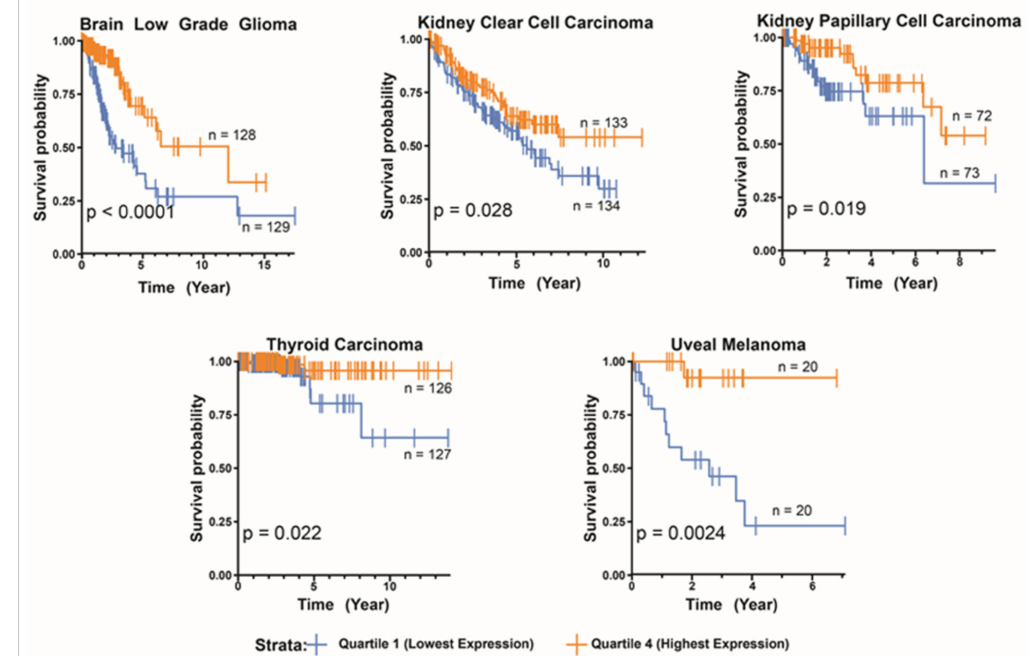
Figure 3. PC transcript levels in select tumor types correlate directly with survival. Normalized PC mRNA expression levels and Kaplan–Meier survival statistics were obtained from the TCGA PANCAN dataset available in the UCSC Xenabrowser for 10,593 samples across all cancer types. Within each cancer type, Kaplan–Meier survival differences between the top and bottom quartiles of PC expression were assessed using a log-rank test. Survival is expressed as the fraction of patients remaining alive from the time of